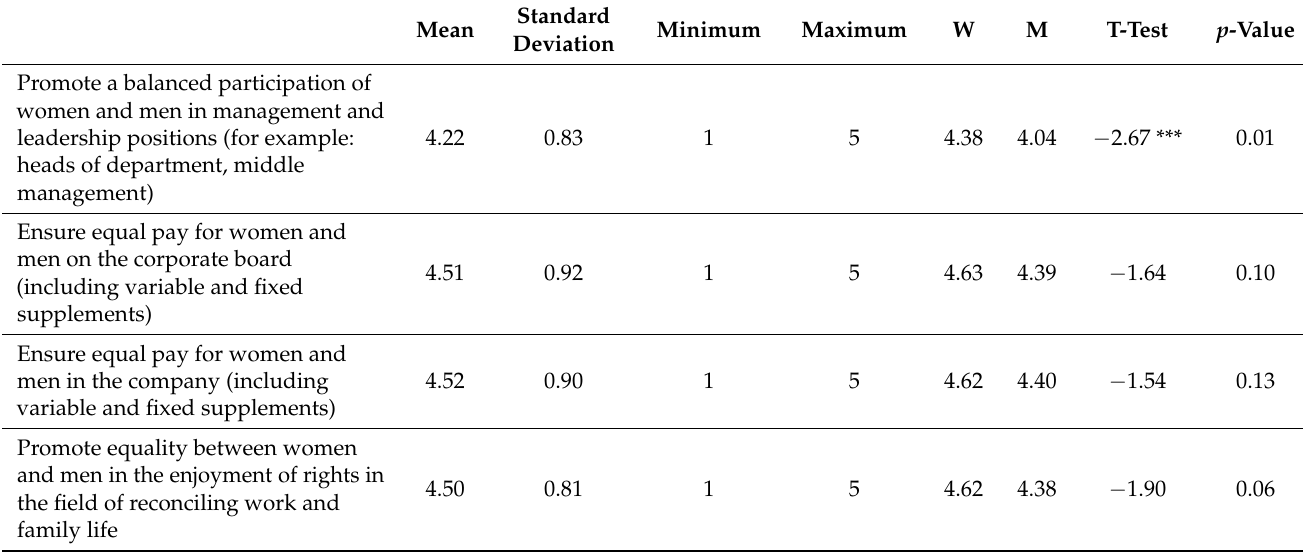
Table A7. Descriptive statistics and mean comparison between women and men who responded to P20—Please indicate, on a scale from 1 = Not Important to 5 = Very Important, to what extent you consider it important that your company adopts measures